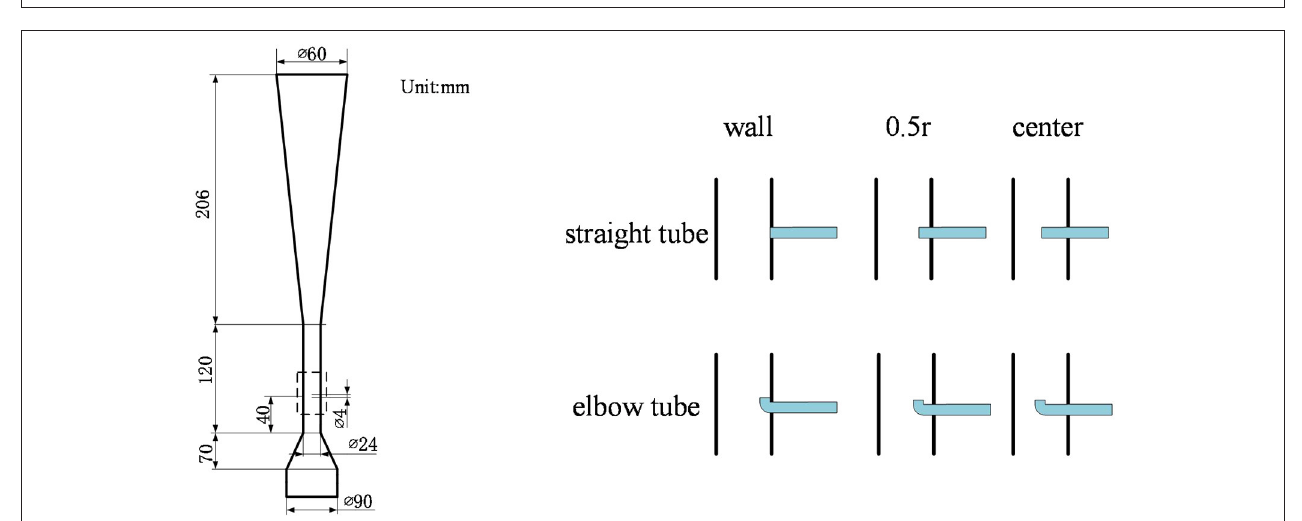
FIGURE 1 | Schematic diagram of experimental loop.